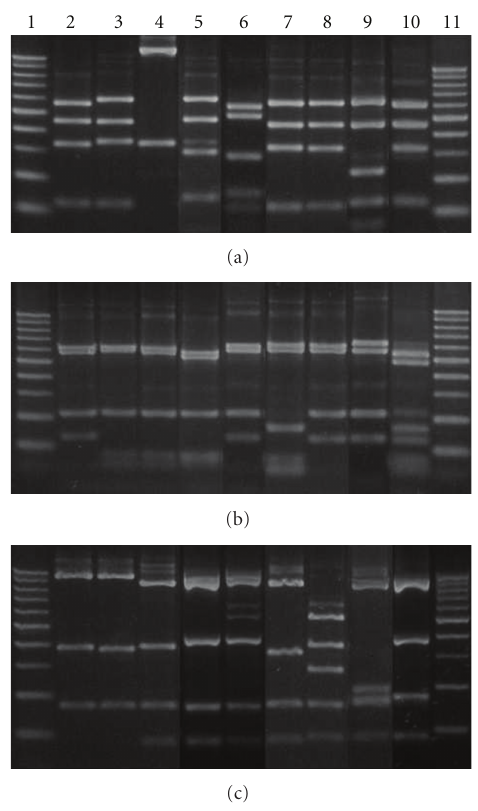
Figure 1: Agarose gel with di ff erent groups of restriction. Line 1 and 11, MW ladder (100bp); line 2, ARDRA group 1 ( L. plantarum ); line 3, ARDRA group 2 ( P. acidilactici ); line 4, ARDRA group 3 ( W. paramesenteroides ); line 5, ARDRA group 4 ( L. salivarius ); line 6, ARDRA group 5 ( L. ruminis ); line 7, ARDRA group 6 ( L. curvatus ); line 8, ARDRA group 7 ( L. farciminis ); line 9, ARDRA group 8 ( L. mucosae ); line 10, ARDRA group 9 ( E. hirae ). Restriction fragments obtained with each enzyme: (a) Hae III, (b) Msp I, (c) Hinf